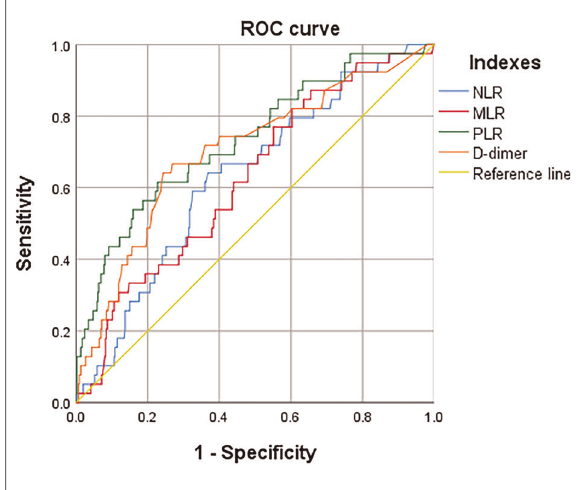
FIGURE 3 ROC to determine the optimal cutoff value for NLR, LMR, PLR, and D-dimer, when in continuous variable.